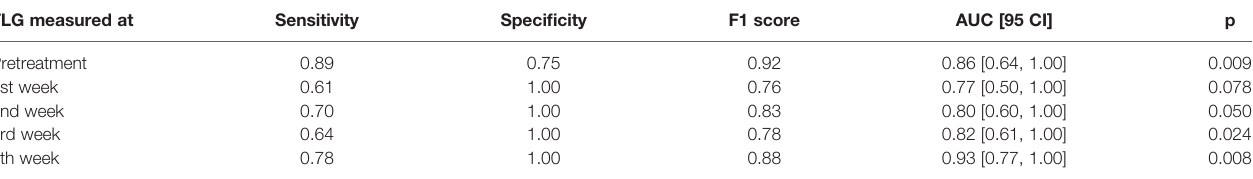
TABLE 5 | ROC results for the total lesion glycolysis